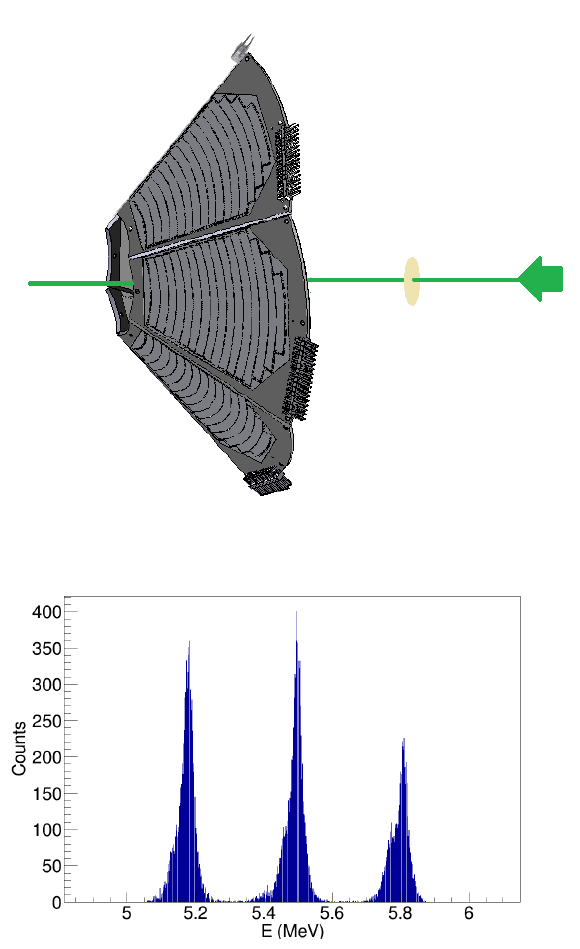
Figure 3. Monitor calibration with a triple alpha